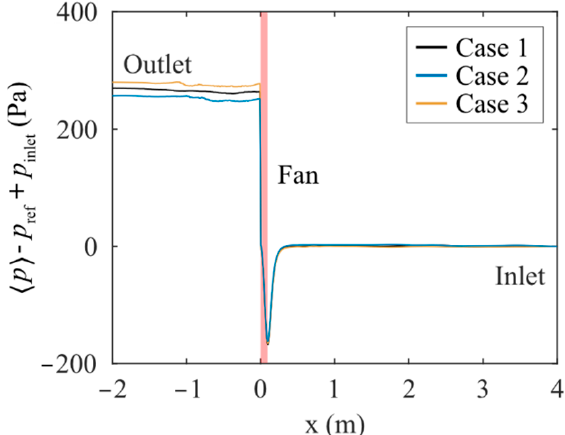
Figure 6. The pressure along the axial axis of the fan across the computational domain. Here, x = − 2 corresponds to the location near the outlet and x = 4 near the inlet. The fan location is marked out with the red zone.